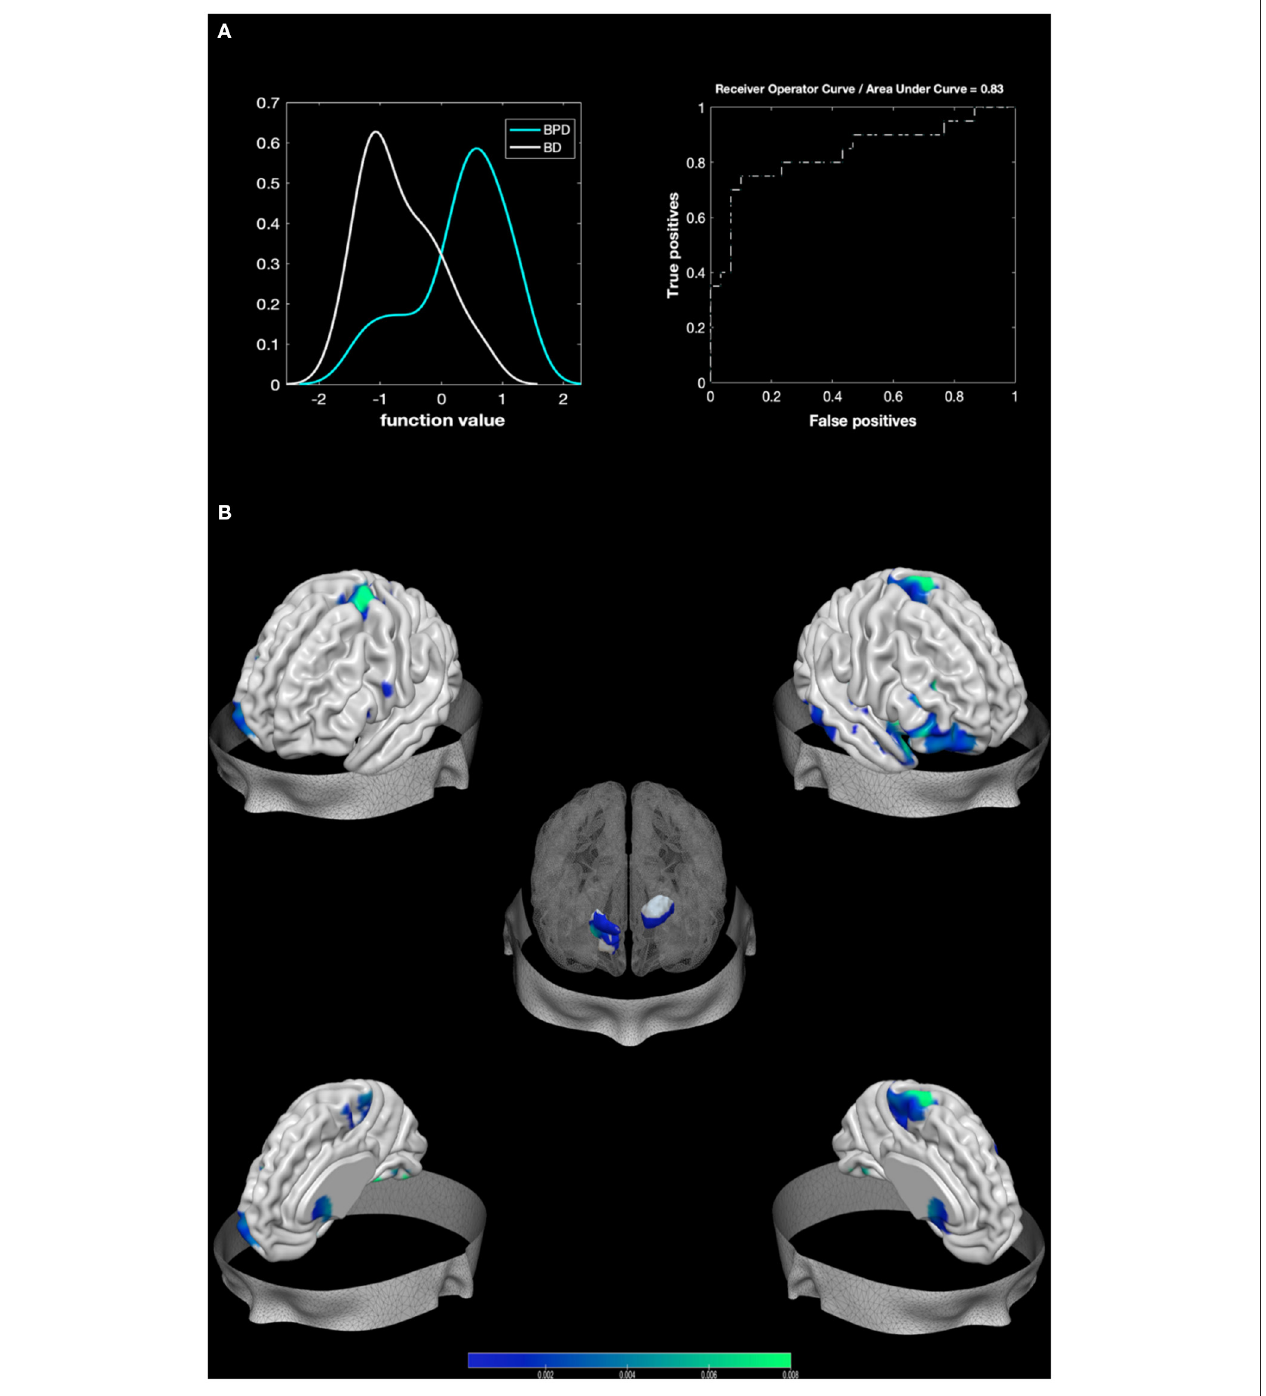
FIGURE 2 | Results from BPD against BD. Multiple Kernel Learning machine classification of patients with Borderline Personality Disorder (BPD) and healthy controls (HC) based on structural (GM) features. (A) Left: Density version of histogram plot of function values. Right: Receiver Operator Curve, Areas Under the Curve = 0.83. ROI weights in percentage and in voxel size are displayed in the two bar plots. (B) Surface plots, including subcortical reconstruction of the significant